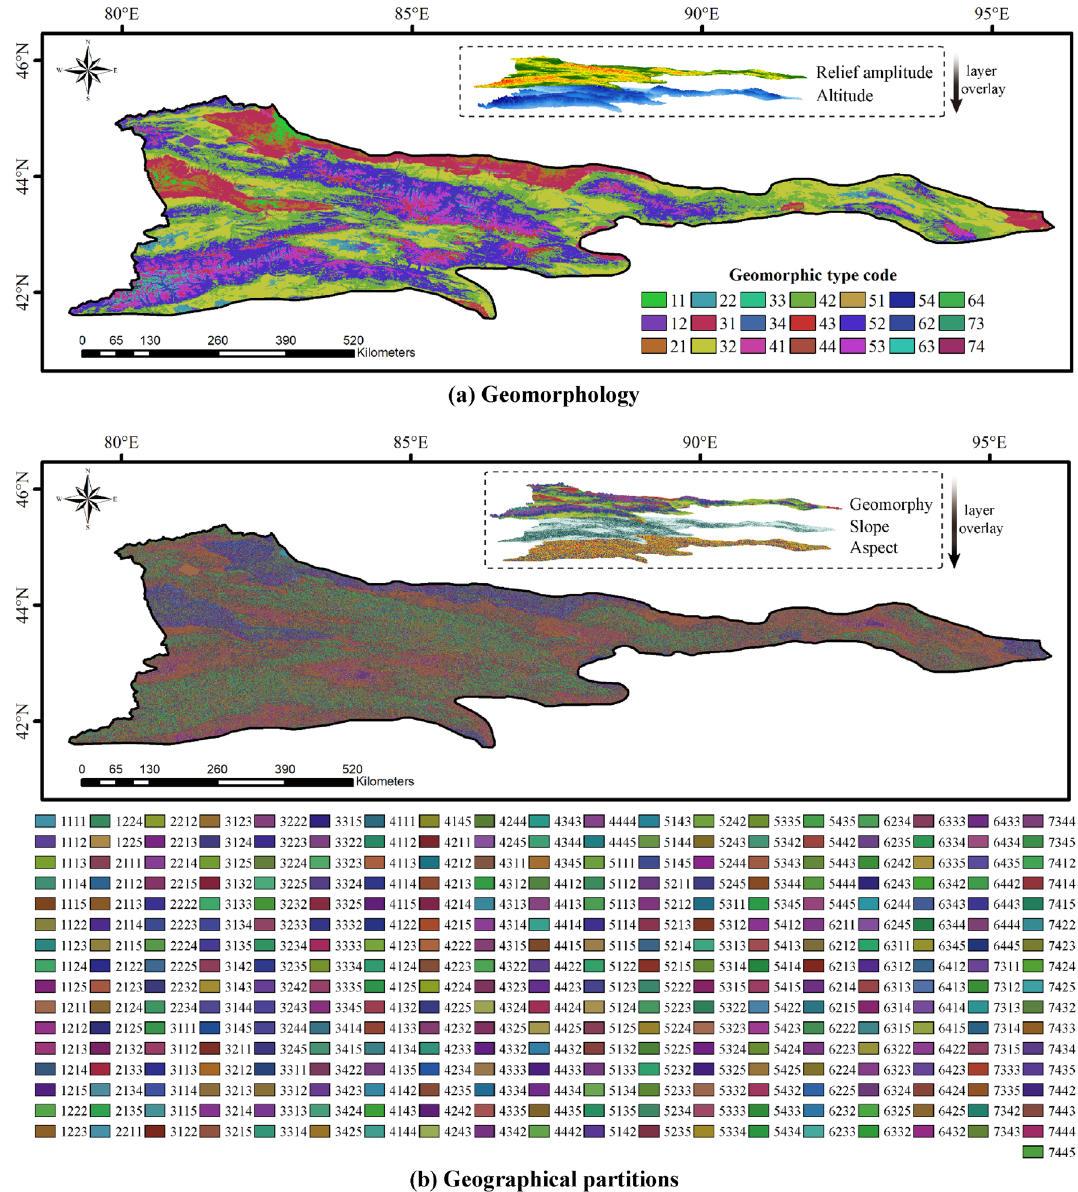
Figure 7. Distribution of geomorphology and geographical partitions in the Tianshan region. The maps were generated by ArcGIS 10.2, URL: http:// suppo rt. esri. com/ Produ cts/ Deskt op/ arcgis- deskt op/ arcmap/ 10-2- 2# overv